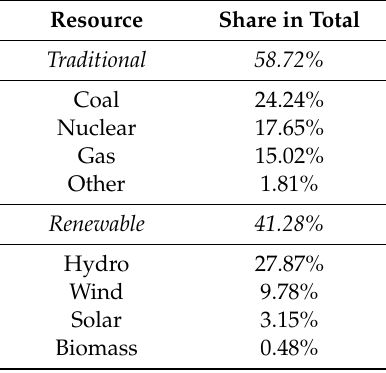
Table 1. Romanian electricity production,